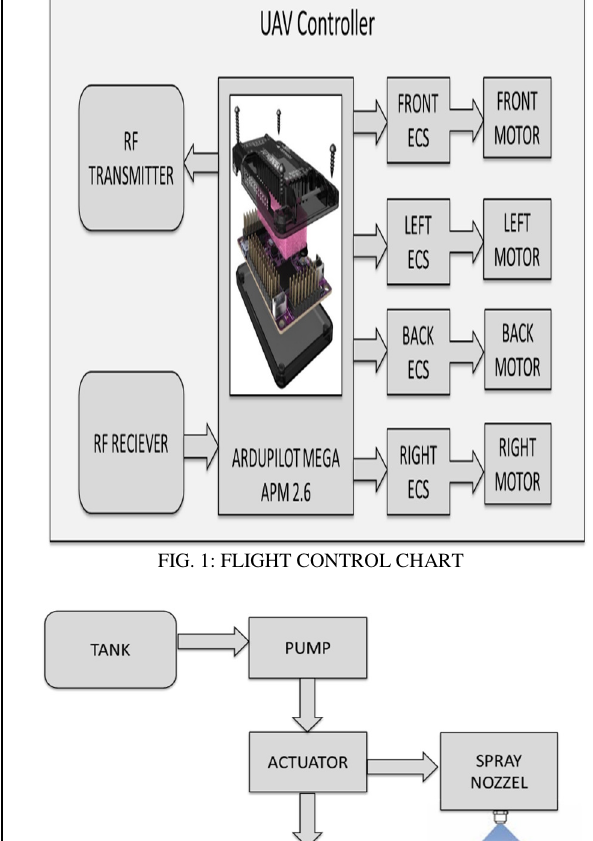
FIG. 2: SPRAYING CONTROL SYSTEM